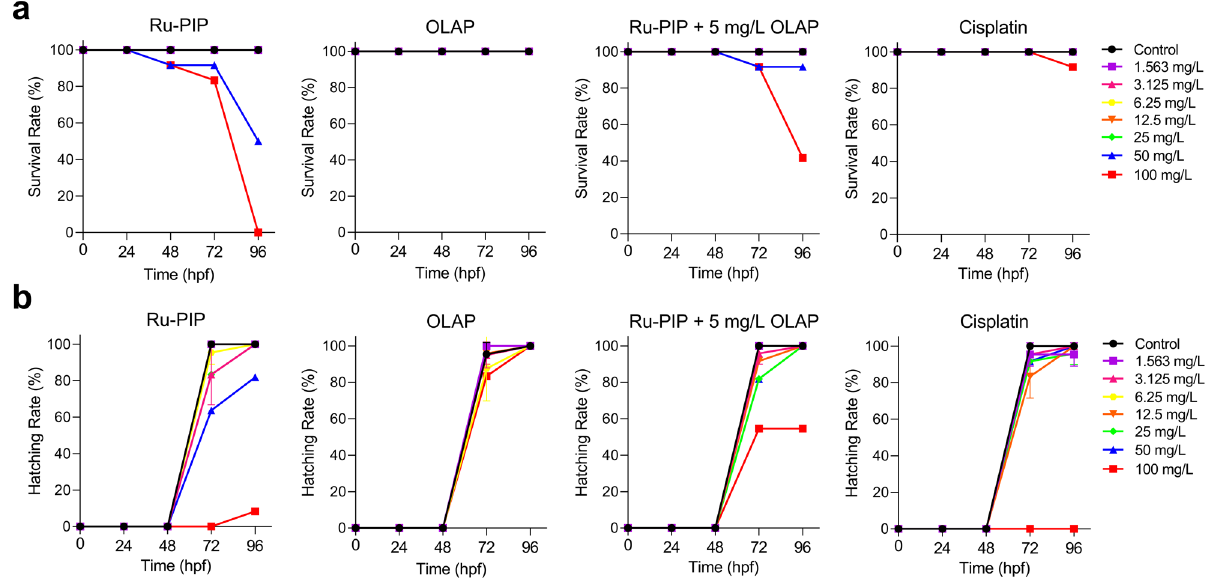
Figure 6. Acute toxicity effects of Ru-PIP without and with Olaparib (5 mg/L) in zebrafish embryos. a) Survival rates and b) hatching rates of zebrafish embryos upon treatment with Ru-PIP, Olaparib, Ru-PIP/ Olaparib combination and cisplatin. Subtoxic concentration of Olaparib was used in the combination treatment (5 mg/L). Data expressed as percentage of survival or hatching of twenty-four embryos from two independent experiments. Hpf = hours post